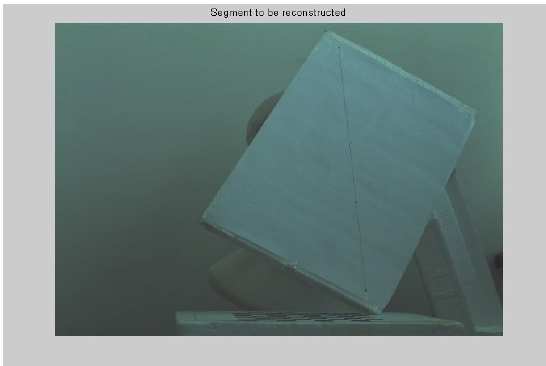
Fig. 6. Segment to be reconstructed